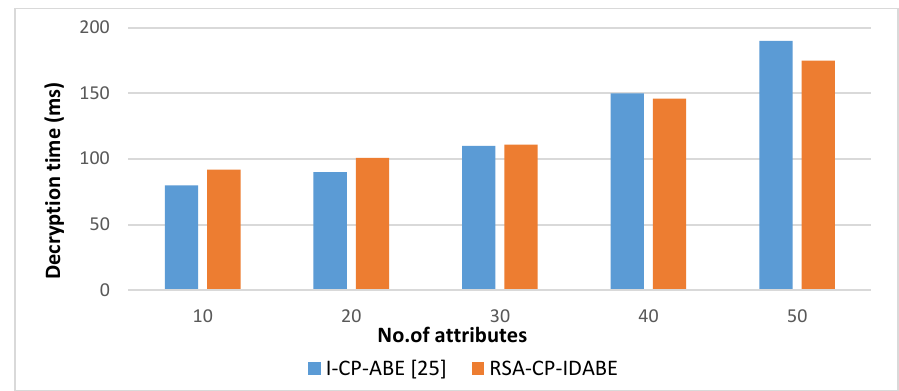
Figure 6. Comparison between the proposed RSA-CP-IDABE and I-CP-ABE for encryption time.